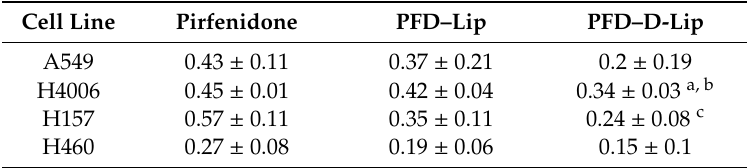
Figure 6. Inhibitory e ff ects on di ff erent NSCLC cell lines ( A ) A549, ( B ) H460, ( C ) H157, and ( D ) H4006, after treatments with PFD, PFD–Lip, and PFD–D-Lip. PFD–D-Lip was found to enhance cytotoxicity e ff ects compared to PFD and PFD–Lip. Cells were incubated with di ff erent concentrations of PFD, PFD–Lip, and PFD–D-Lip for 72 h; and cell viability was determined using MTT assay. Data represent mean ± SD (n = 3). ( E , F ) Safety studies. Cytotoxicity studies on A549 ( E ) and H1299 ( F ) cell lines after treatment with Blank Lip / Blank–D-Lip. Cells were incubated with equivalent amounts of Blank Lip and Blank–D-Lip to 0.1, 0.2, 0.5, and 1mg / mL of PFD–Lip and PFD–D-Lip, respectively, for 72 h; cell viability was determined using MTT assay. Cells without treatment were considered as control (100%). Data represent mean ± SD ( n = 3). Table 2. IC 50 of Pirfenidone, PFD–Lip and PFD–D-Lip in four NSCLC cell